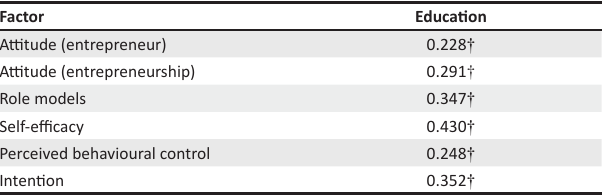
TABLE 11: The Spearman correlations between role model and the dimensions of entrepreneurial intentions ( N =